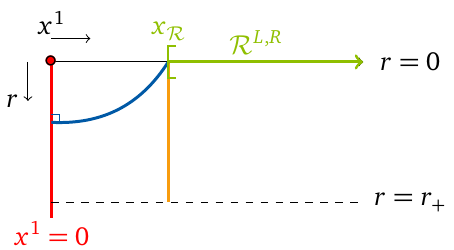
Figure 5: The candidate RT surfaces in one of the exterior regions. The orange line entering the horizon is the Hartman-Maldacena surface, whereas the blue arc which ends perpendicularly on the brane is the island-producing exterior